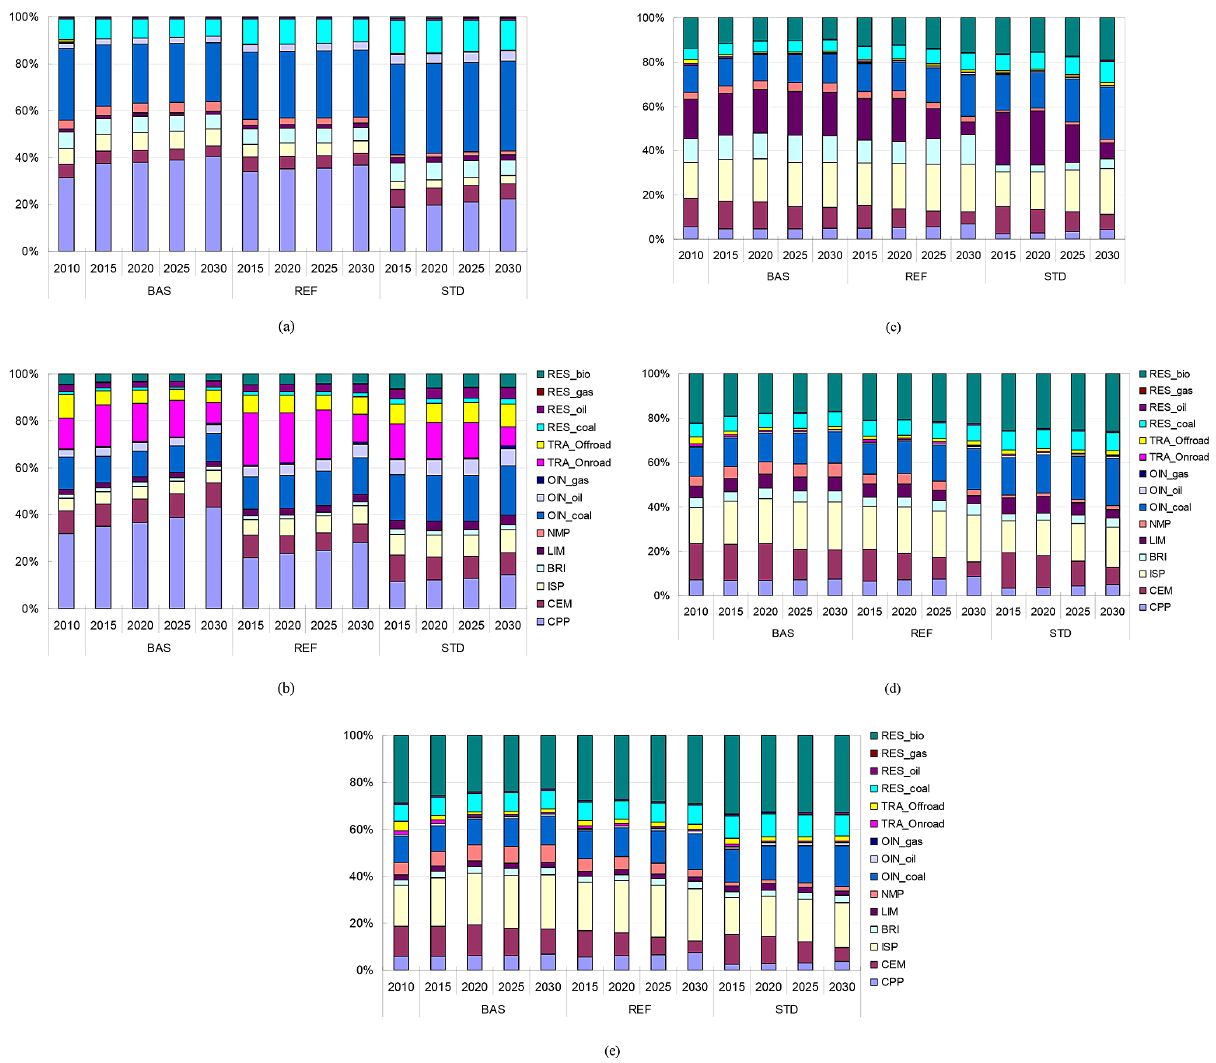
Figure 3. Shares of China’s anthropogenic emissions by source for 2015, 2020, 2025 and 2030. Values are for the NPS activity scenario and three emission control levels: BAS, REF, and STD. (a) SO 2 ; (b) NO x ; (c) PM; (d) PM 10 ; and (e) PM 2 . 5